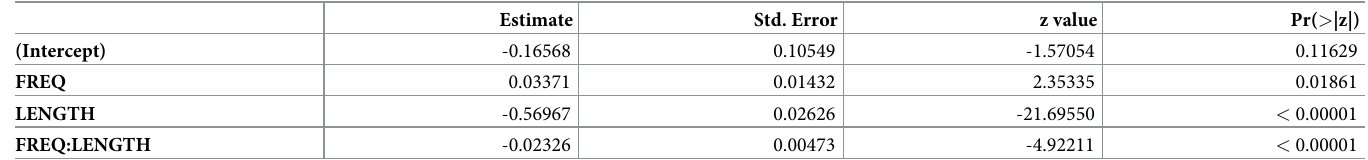
Table 4. Fixed effects of optimal GLMM (Model 1’) for the probability of word skipping.